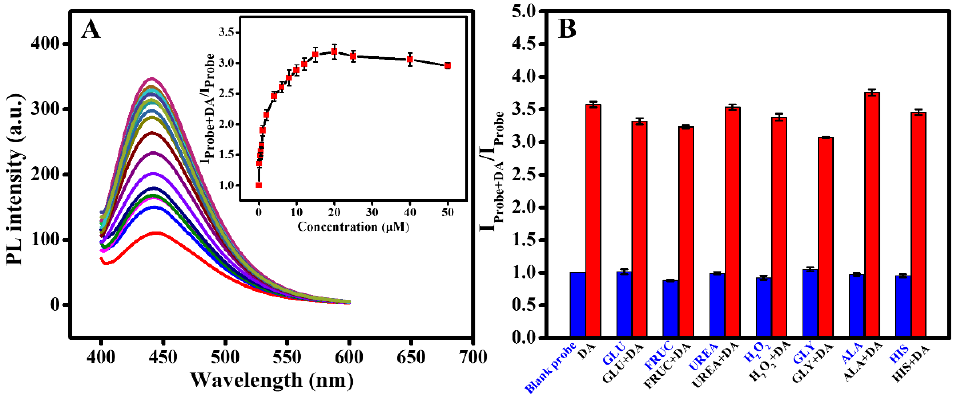
Figure 8. ( A ) Enhancement effect of DA on fluorescence intensity of NPCDs/Fe 3+ probe (inset: calibration curve between I Probe+DA /I Probe and concentration of DA), ( B ) selectivity of NPCDs/Fe 3+ probe towards different interferences in the presence and absence of DA in an equal concentration of 5 µM.